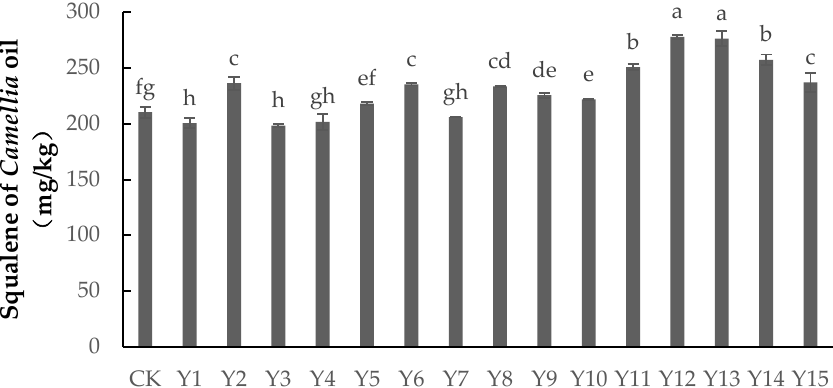
Figure 2. The content of squalene in Camellia oil under different treatments. Note: Data indicate mean ± SE ( n = 3). Different letters indicate significant differences ( p < 0.05) between different treat- ments.